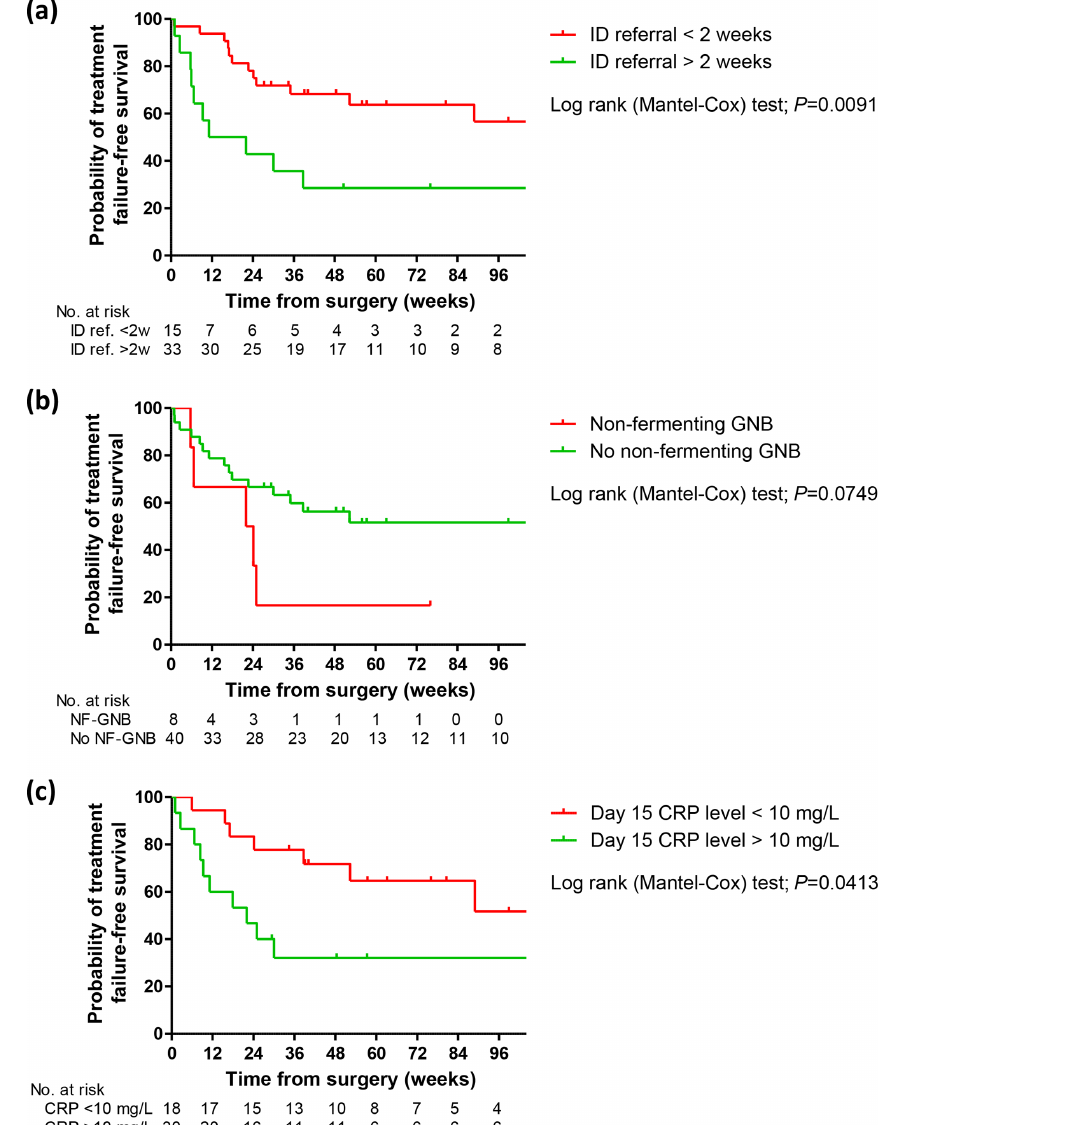
Figure 1. Kaplan–Meier curves showing the probability of failure-free survival according to early ID specialist referral (a) , non-fermenting GNB infection (b) , and normalization of the biological inflammatory syndrome (c) . ID, infectious disease; CRP, C-reactive protein; GNB, Gram-negative